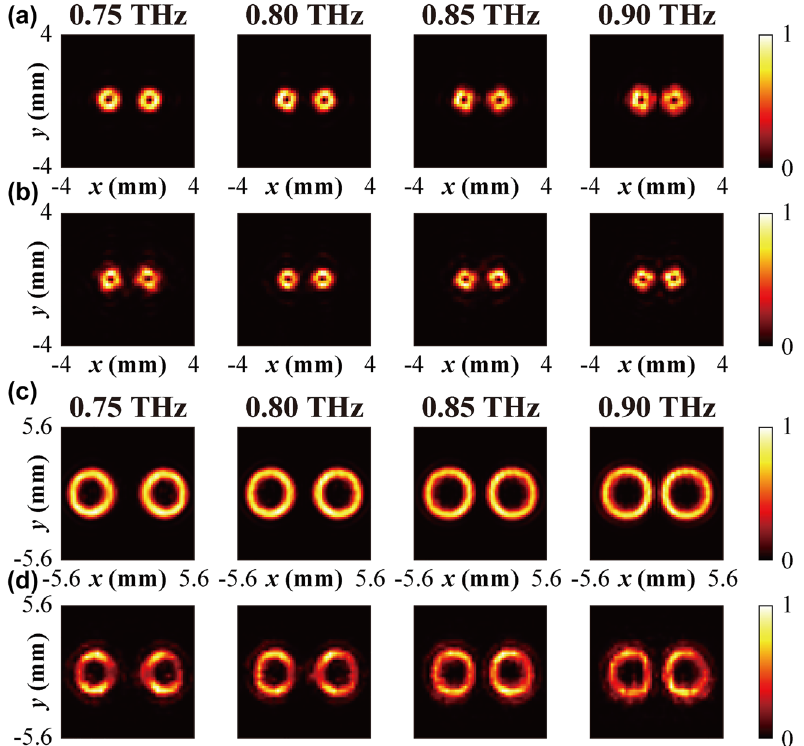
Figure 3: Generation of two-channel vortex beams and Q-PVBs. (a) Calculated and (b) measured intensity distributions for